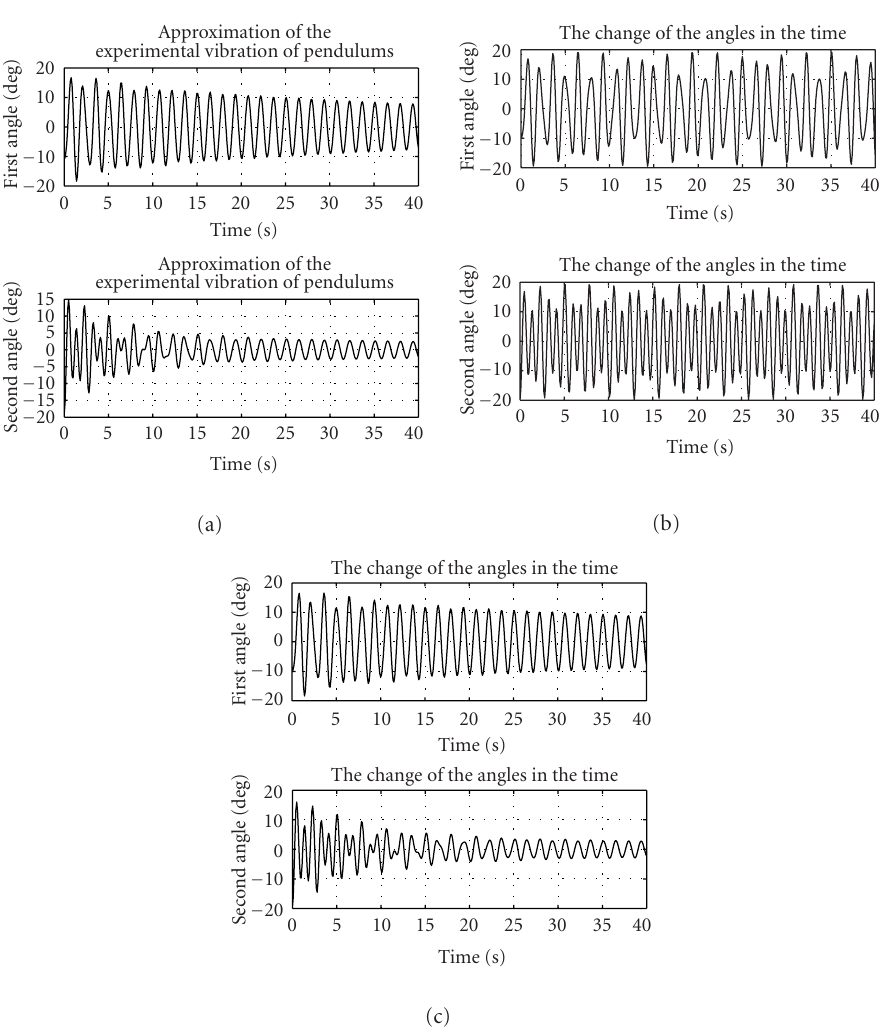
Figure 5.1. Experimental picture of the vibration of the pendulums: (a) oscillation of the experi- mental pendulums; (b) computed free oscillation of the pendulums; (c) computed free oscillation of the pendulums with friction estimated from experiments. The initial conditions are ϕ 1 = − 10 ◦ , ϕ 2 = − 20 ◦ , and initial parameters are m 1 = m 2 = 1 . 57 kg, L 1 = L 2 = 0 . 3m, Ψ = 45 ◦ , ϕ 1 = − 10 ◦ , ϕ 2 = − 20 ◦